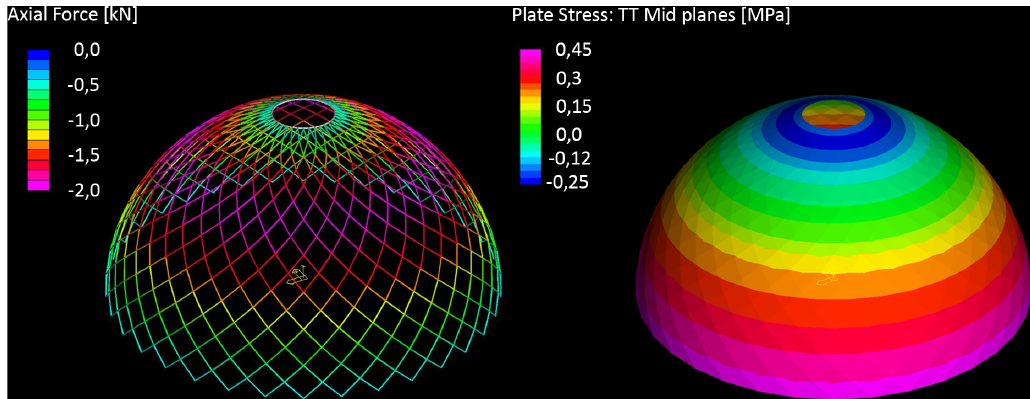
Figure 12: Shell displacements. Left: axial forces in truss elements. Right: Membrane stresses in hoop direction tangent to the surface (purple = tension, blue = compression)